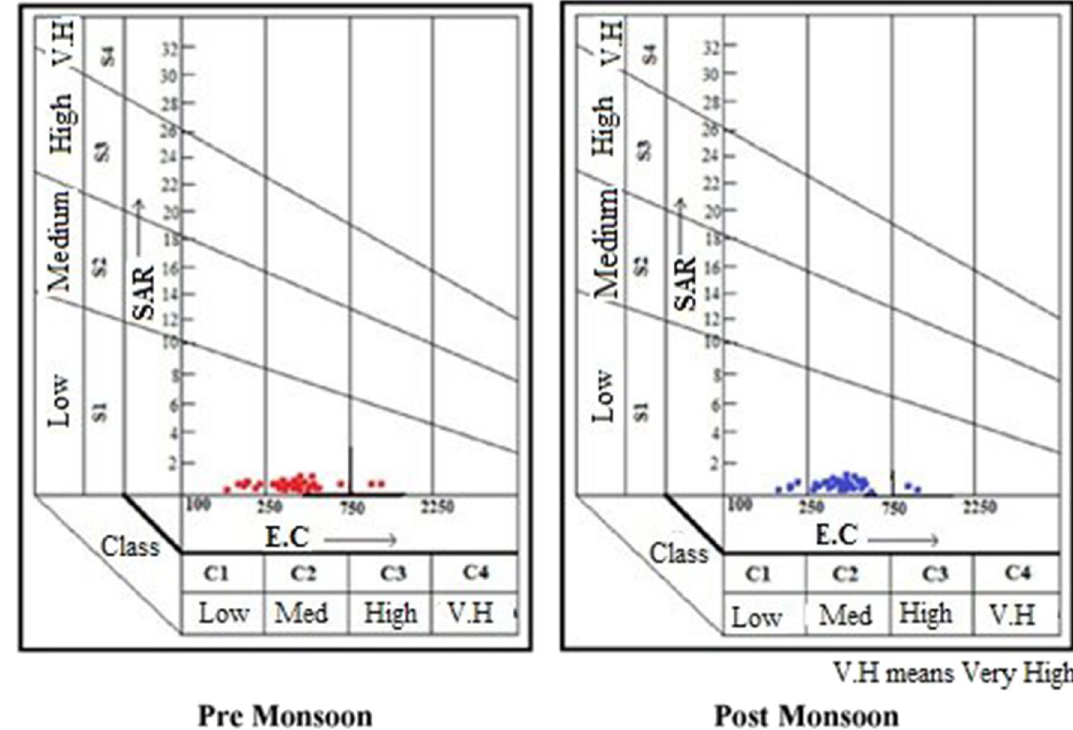
Fig. 7 USSL classification of groundwater in the study area